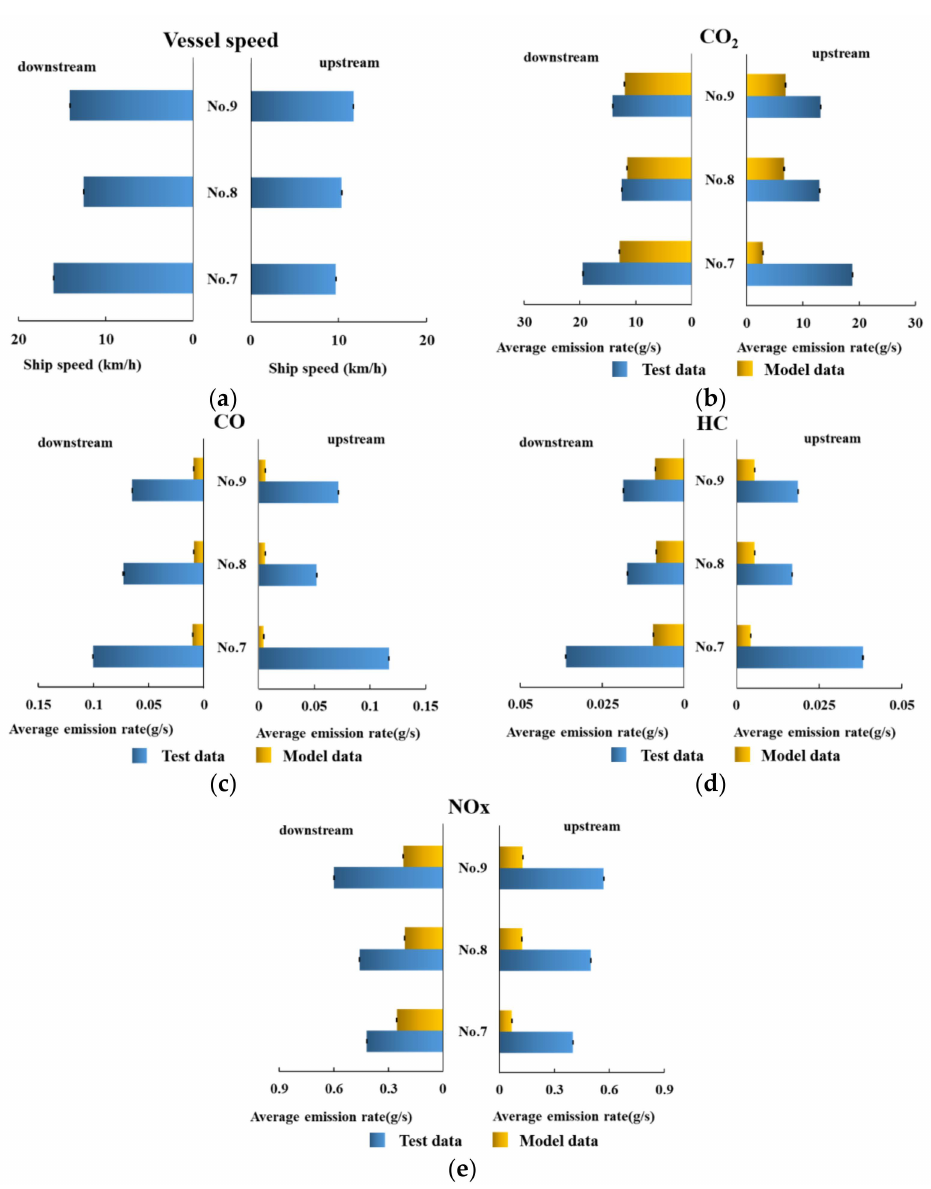
Figure 5. Comparisons of ( a ) vessel speed and average emission rates of ( b ) CO 2 , ( c ) CO, ( d ) HC, and ( e ) NOx for upstream and downstream voyages during cruise